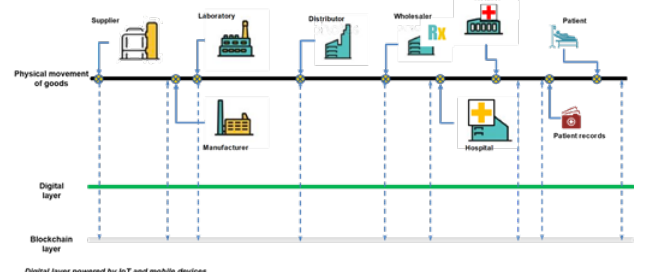
Figure 4. Implementing blockchain